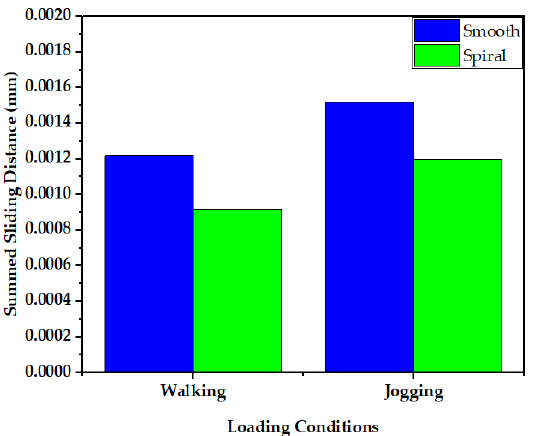
Figure 13. Comparison of sliding distance of smooth and spiral head-neck tapered joints during walking and jogging loading conditions.